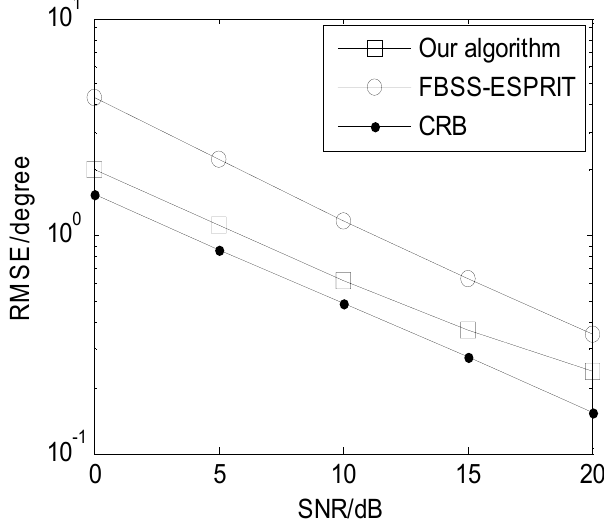
Figure 3. Angle estimation performance comparison for ULA ( M = 12, J = 100, and K =